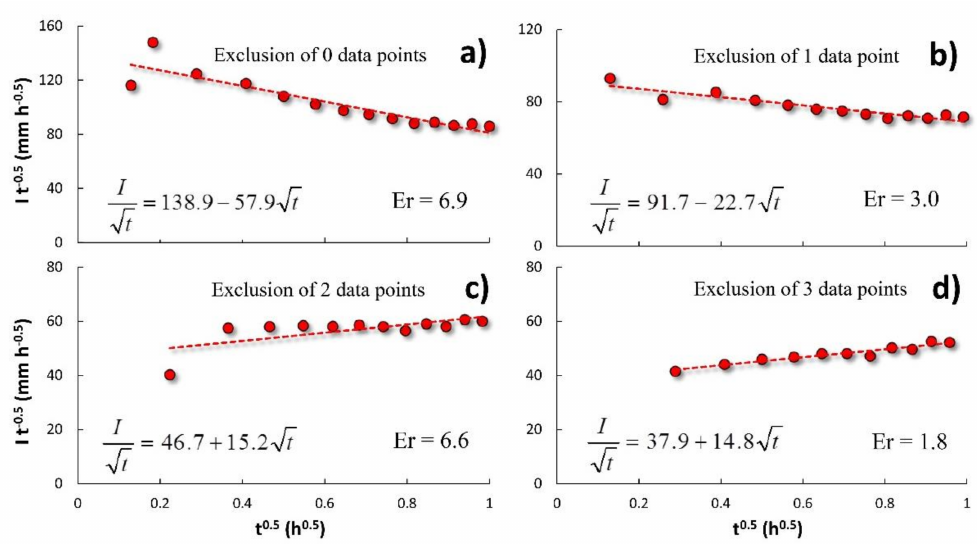
Figure 4. Examples of the estimation of the C 1 (mm · h − 0.5 ) and C 2 (mm · h − 1 ) parameters by the cumulative linearization (CL) approach excluding a different number of data points of an infiltration run carried out at the burnt site in 2017. The values of the ratio between the cumulative infiltration, I (mm), and the square root of time, t (h), are plotted against the square root of t . ( a ) Exclusion of zero data points: C 2 < 0. ( b ) Exclusion of one data point: Lower Er value (3.0%) but C 2 < 0. ( c ) Exclusion of two data points: C 2 > 0 but Er = 6.6%. ( d ) Exclusion of three data points: C 2 > 0 and lowest Er value (1.8%; selected case).